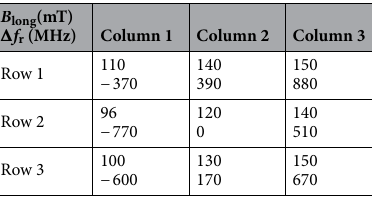
Table 3. B long and (cid:31) f r at each QD position; (cid:31) f r is calculated with respect to the center QD.